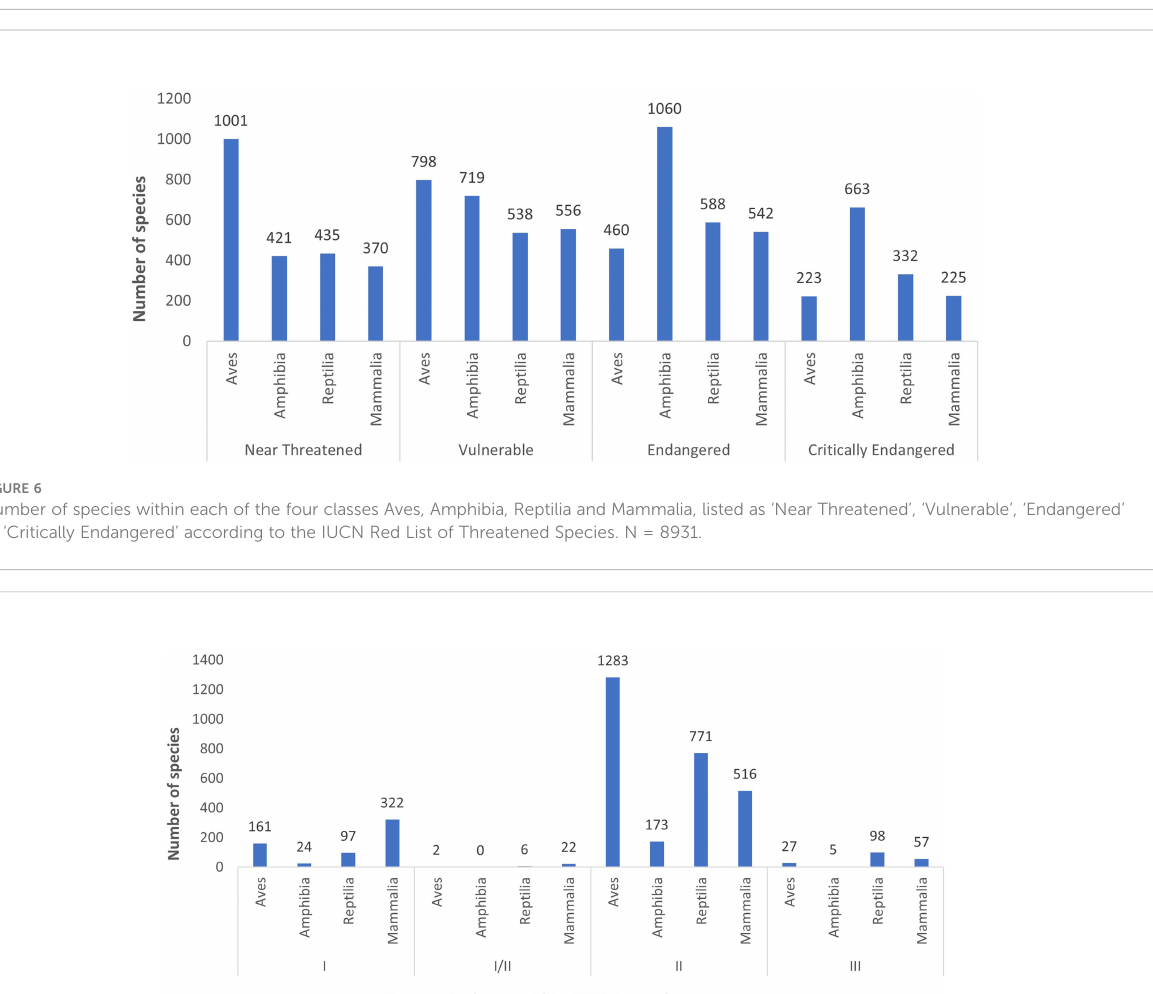
FIGURE 5 Number of species listed in each of the CITES Appendices (I, II and III), for taxonomic classes with > 500 species listed.